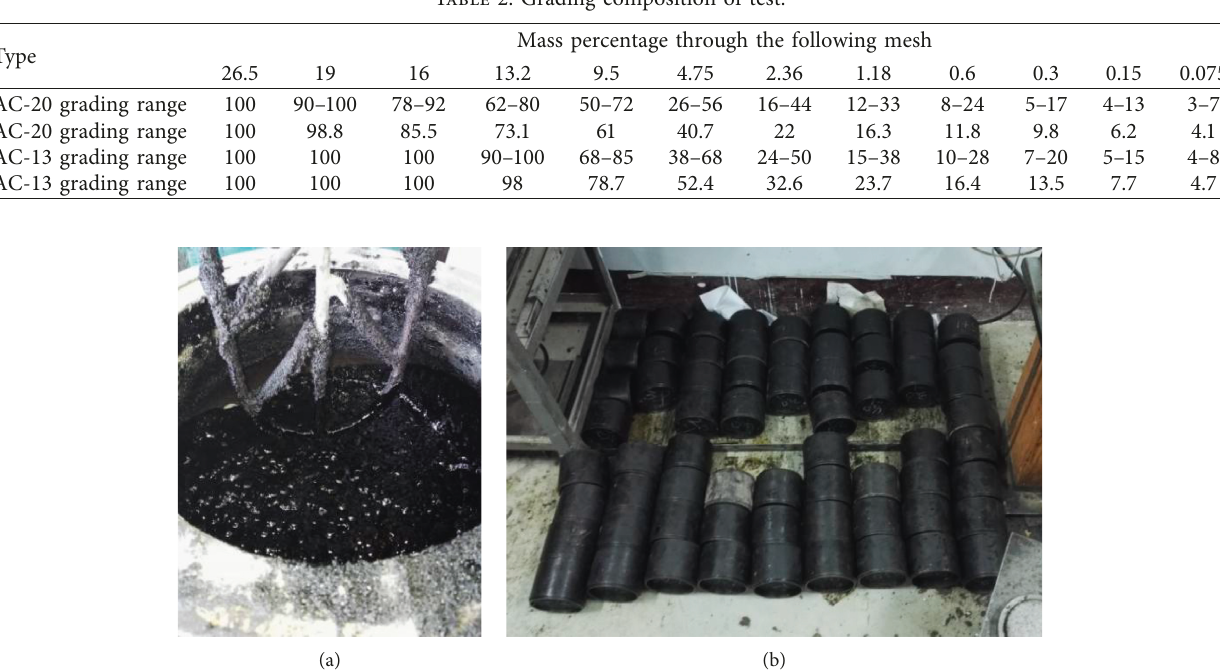
Table 2: Grading composition of test.